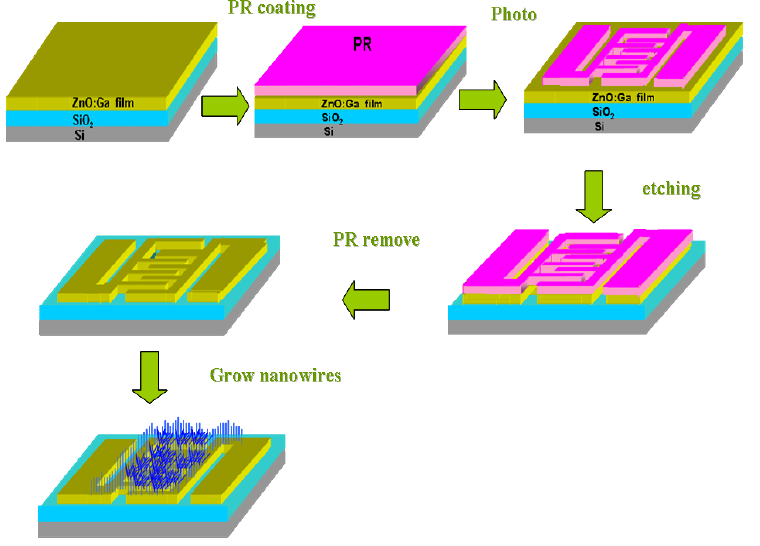
Figure 1. The growth and processing steps of ZnGa based